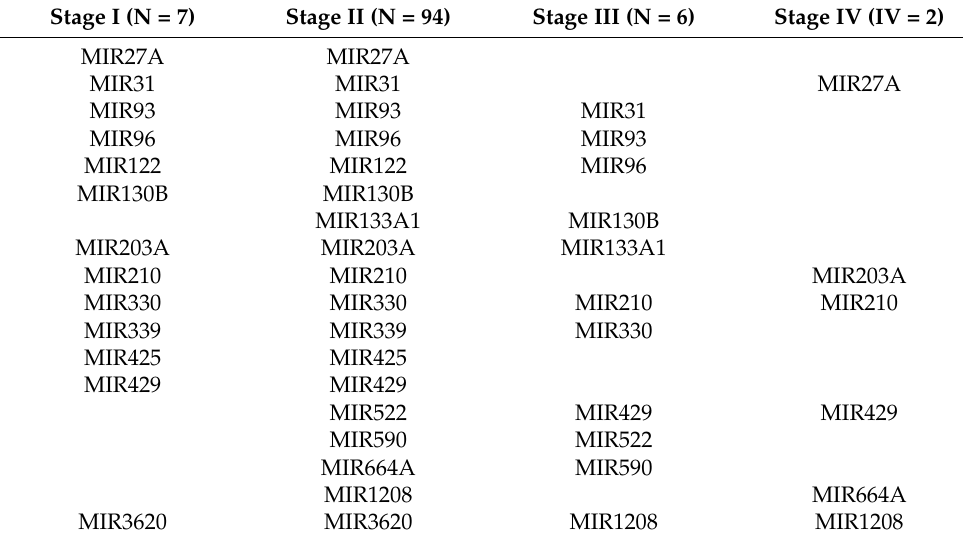
Table 1. MIR alterations across pancreatic cancer